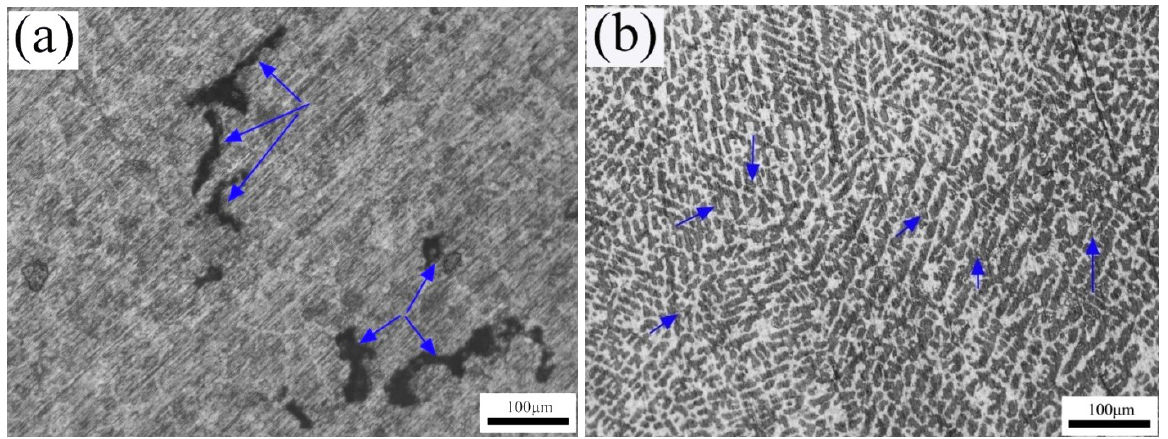
Figure 5. Surface morphology of alloys after immersion tests in 3.5 wt.% NaCl solution for 15 days: ( a ) TiZr 0.5 NbCr 0.5 ; ( b ) TiZr 0.5 NbCr 0.5 V and ( c ) TiZr 0.5 NbCr 0.5 Mo